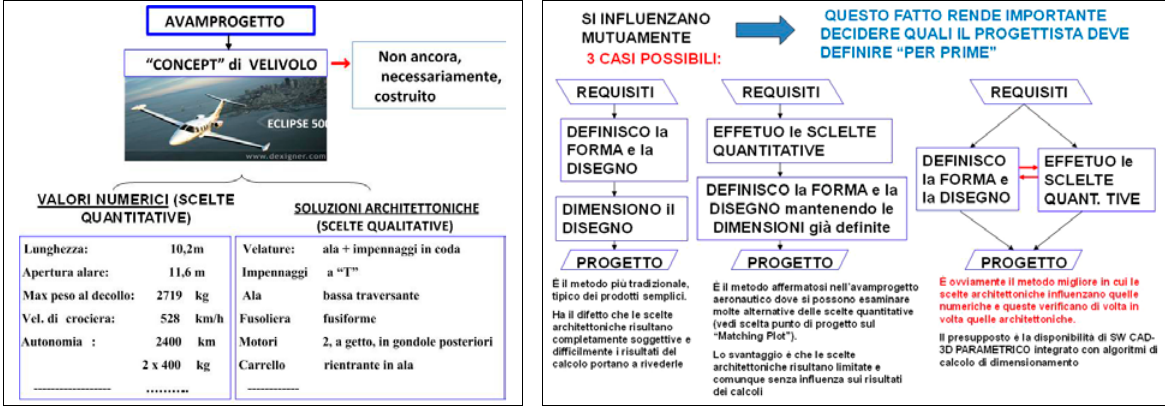
Fig. 2. Architectural characteristics of an aircraft Fig. 3. Approach modalities to the architectural definition in C.D.